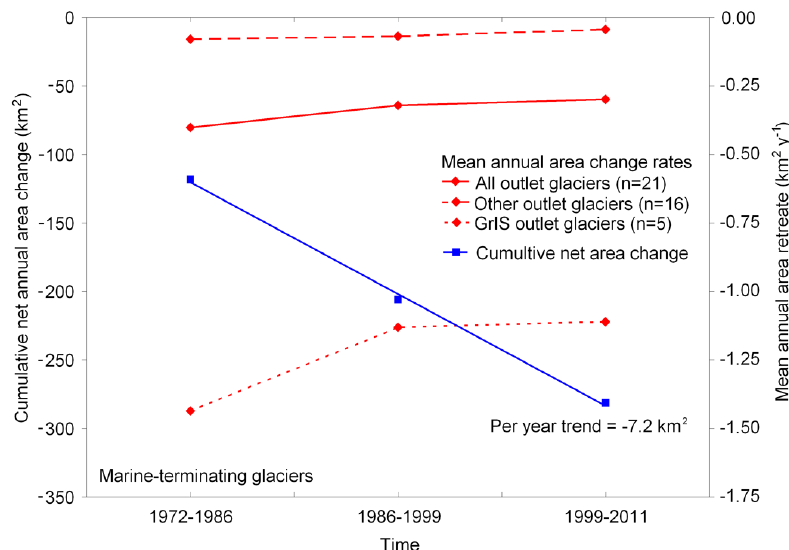
Fig. 6. Mean annual area change rates and cumulative net area change for all 21 marine-terminating glaciers, the five GrIS outlet glaciers, and other sixteen outlet glaciers for the Ammassalik region